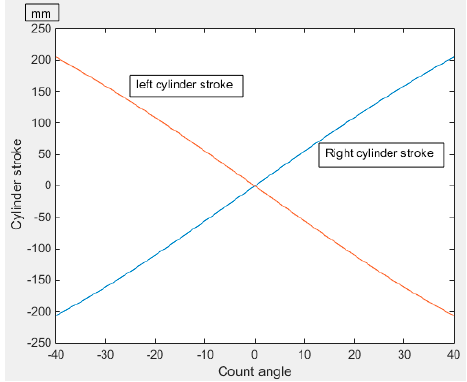
Figure 8. Variation curve of the steering cylinder stroke with steering angle.